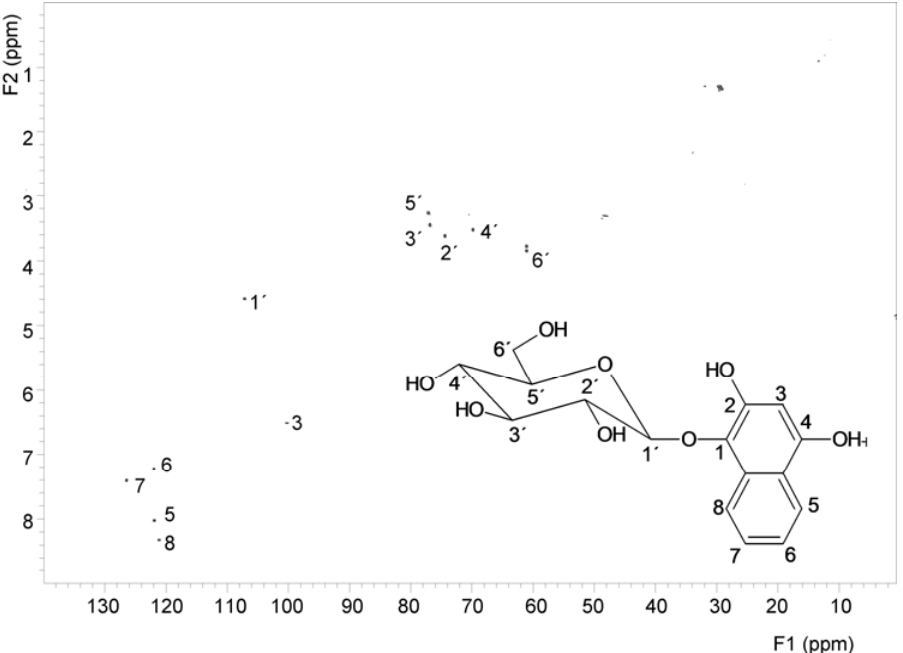
Figure 5. HSQC spectrum and the signal assignment of 1,2,4-trihydroxynaphthalene-1- O